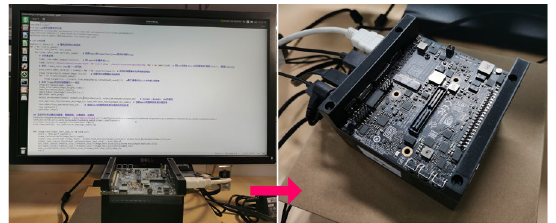
Fig. 14 Platform for runtime